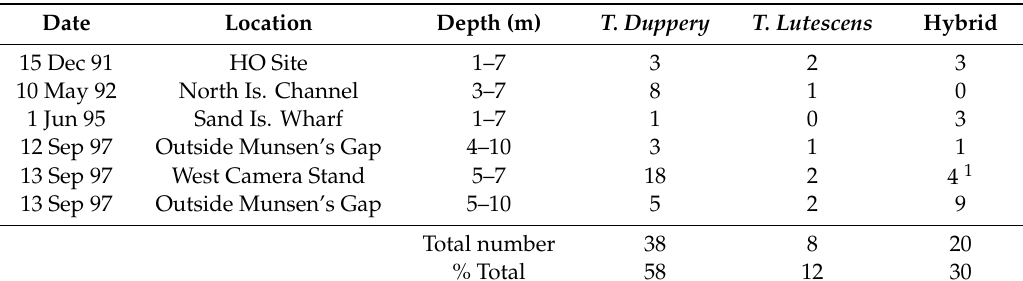
Table 1. Surveys of Thalasssoma species.